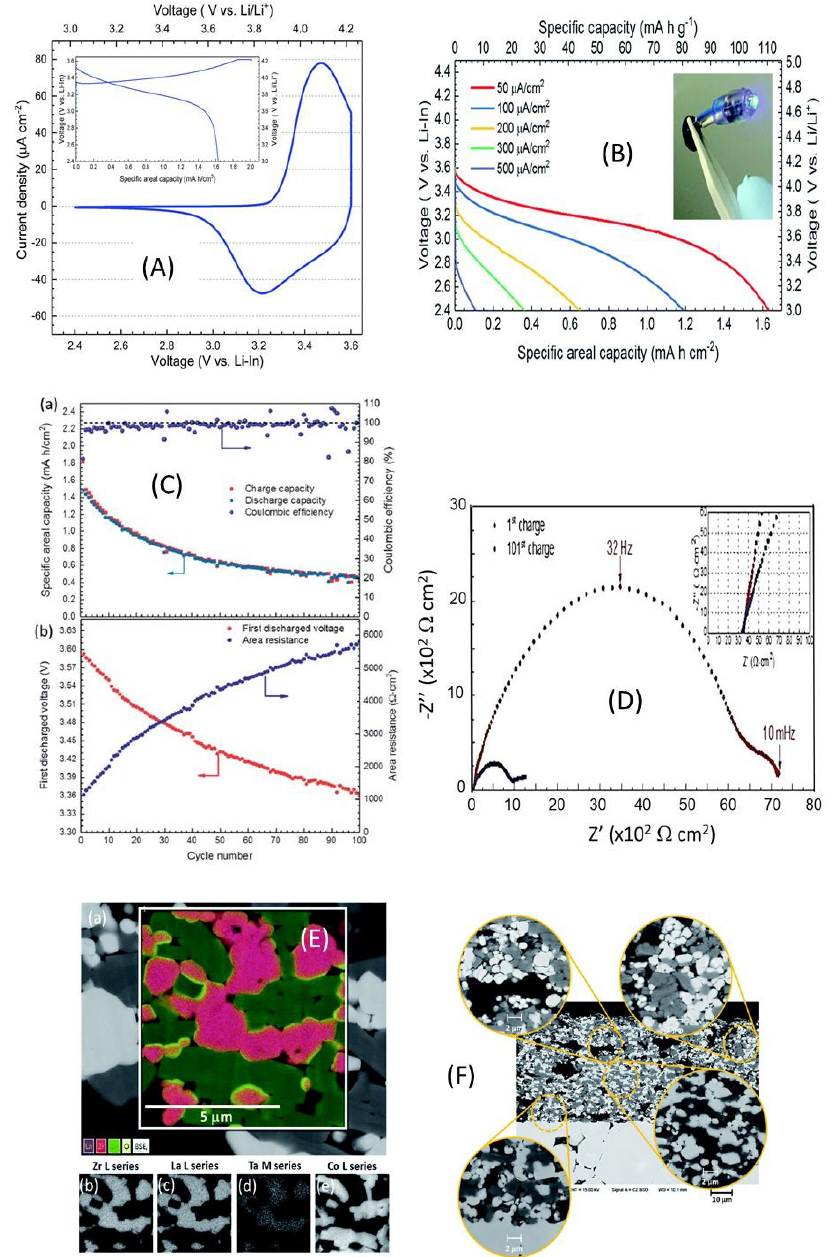
Figure 26. ( A ) Cyclic voltammogram of the LCO | Ta-LLZO | Li-In ASSB collected in the voltage range of 2.4–3.6 V vs. Li–In. The inset illustrates the first cycle charge–discharge performance of the SSLB at a constant current density of 20 μA cm −2 before it was subjected to CV scanning. ( B ) Discharge profile of the SSLB at different current densities. The discharge profiles of the cell were obtained in sequence from the lowest to the highest current density. Therefore, the capacity fading owing to the cycling of the cell was not taken into account for capacity calculations. The inset depicts the SSLB, which features a black composite polymer electrolyte in front, which lights up an LED. ( C ) Long-term charge–discharge cycling of SSLB ( a ), and first discharge voltage points for the cycles and calculated area resistance of the SSLB ( b ). ( D ) Electrochemical impedance spectroscopy diagram of the SSLB before and after long-term galvanostatic cycling. ( E ) (a) SEM and energy-dispersive X-ray spectroscopy (EDS) mapping of the sintered composite positive electrode. Monochromatic EDS mappings of ( b ) Zr, ( c ) La, ( d ) Ta, and ( e ) Co. ( F ) Scanning electron microscopy (SEM) cross-section images of the SSLB that underwent 100 galvanostatic charge–discharge cycles at 50 °C. Reproduced with permission from [357]. Copyright 2019 Royal Society of Chemistry.